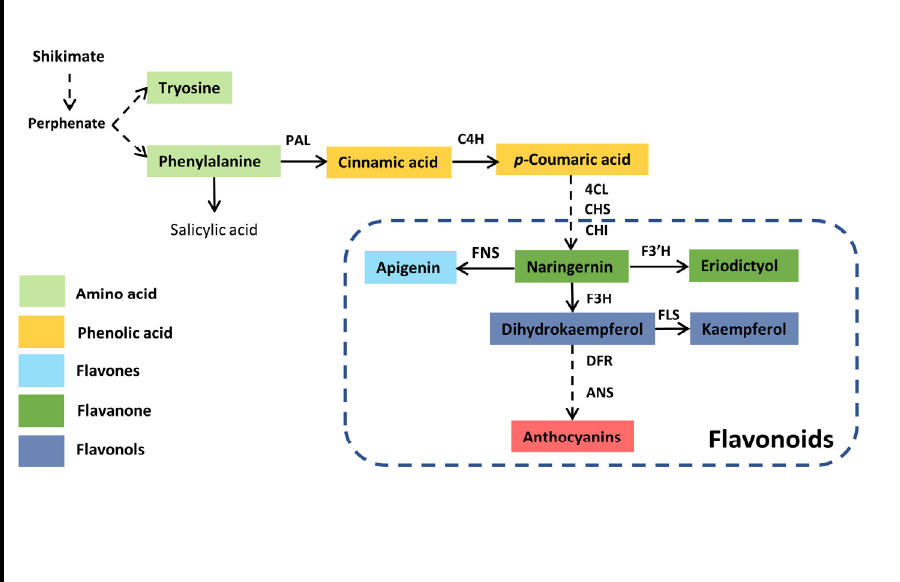
Figure 1. Illustration of the biosynthetic pathways leading to the major groups of phenolic com- pounds in Populus . [22].